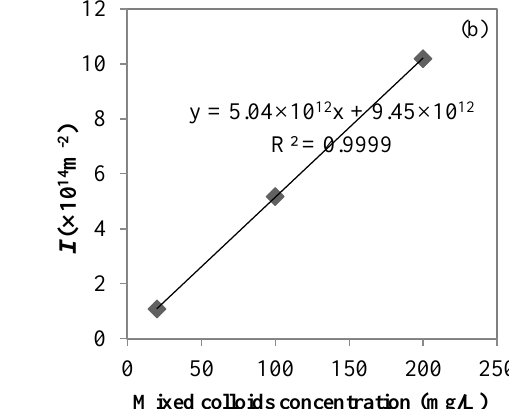
Figure 4. Cake layer model fitting for the UF process of a sodium alginate and bovine serum albu- min (each 10 mg/L) mixed solution ( a ) and the correlation between I and the feed colloid concentra- tion ( b ).